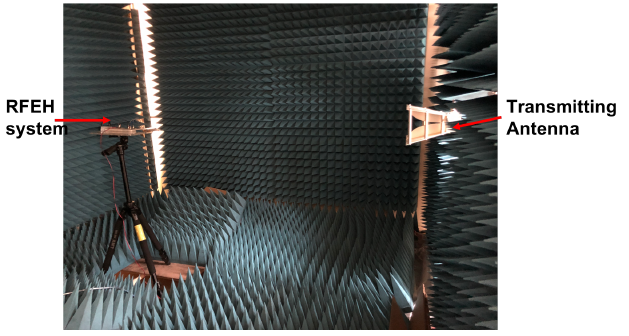
Figure 15. Measurement setup in an anechoic